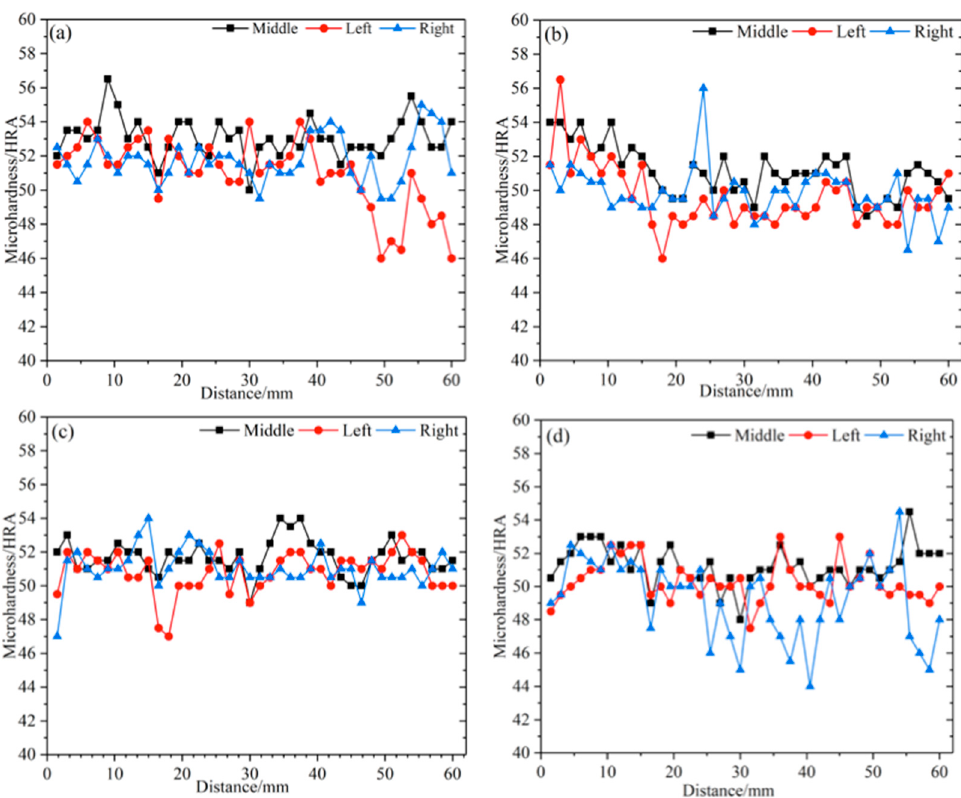
Figure 10. The hardness curves of four specimens: ( a ) deposited part A, ( b ) deposited part B, ( c ) deposited part C, ( d ) deposited part D.